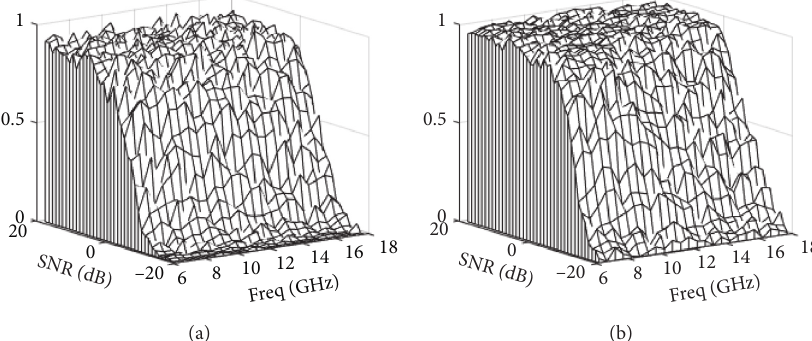
Figure 7: Array-3 probability of AoA estimation versus frequency and SNR: (a) RMSE ≤ 1 ° and (b) RMSE ≤ 5 ° , when M + 1 � 1025 for WF-2.